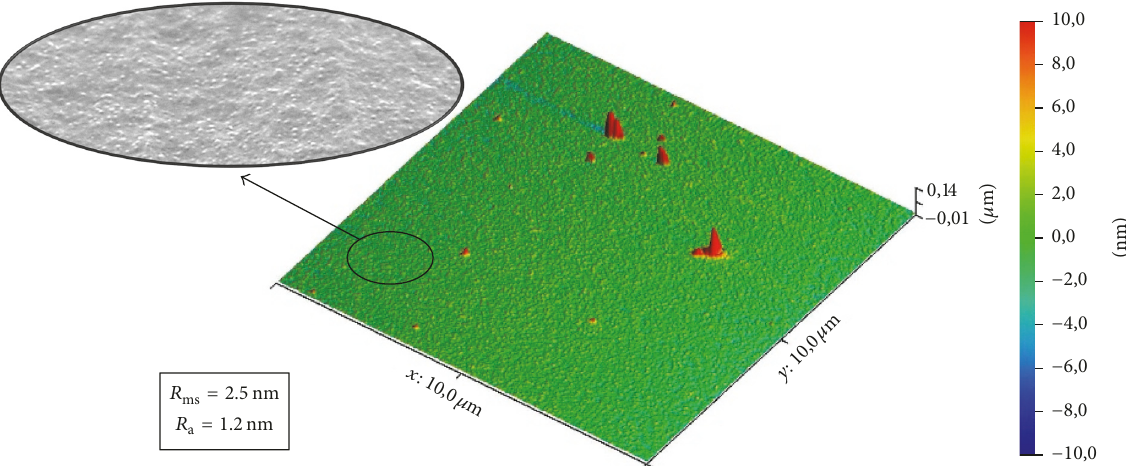
Figure 15: AFM image of the AlTiN coating surface deposited at 300 Hz for a scanned area of 10 × 10 𝜇 m with a maximal structure height of 140nm and a maximal structure depth of − 13 nm. The SEM image on the left side illustrates the surface structure in the nanometre range as an example for the marked surface area.